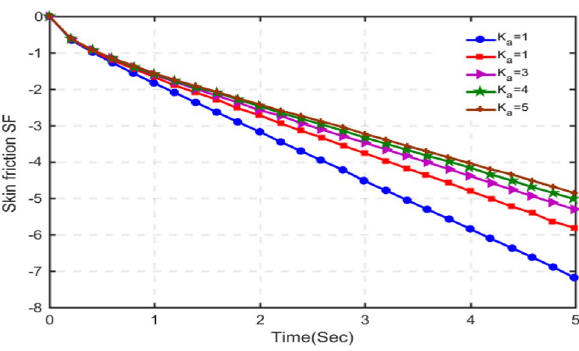
Figure 16. Variation in skin-friction for diverse values of